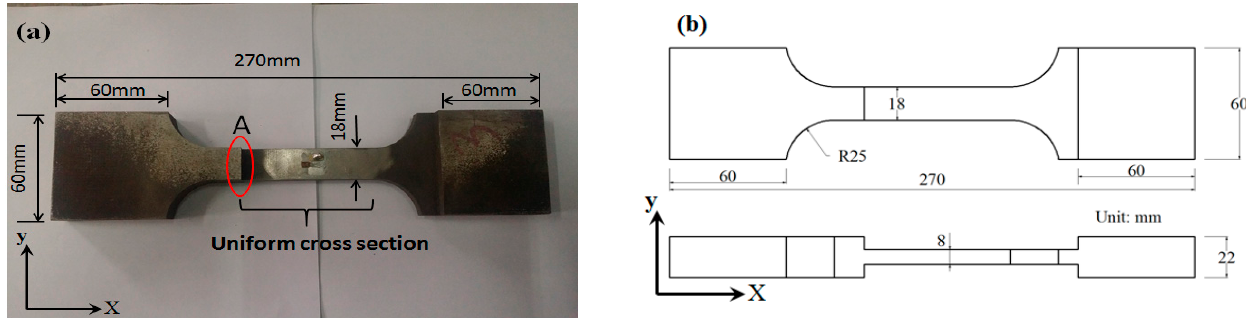
Figure 3. ( a ) The specimen and its dimensions after a fatigue test; ( b ) the dimensions of the specimen before a fatigue test.